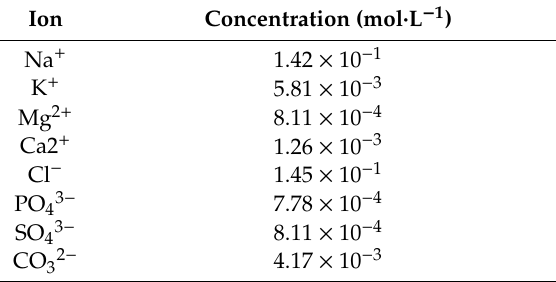
Table 2. Ion concentration of Hank’s